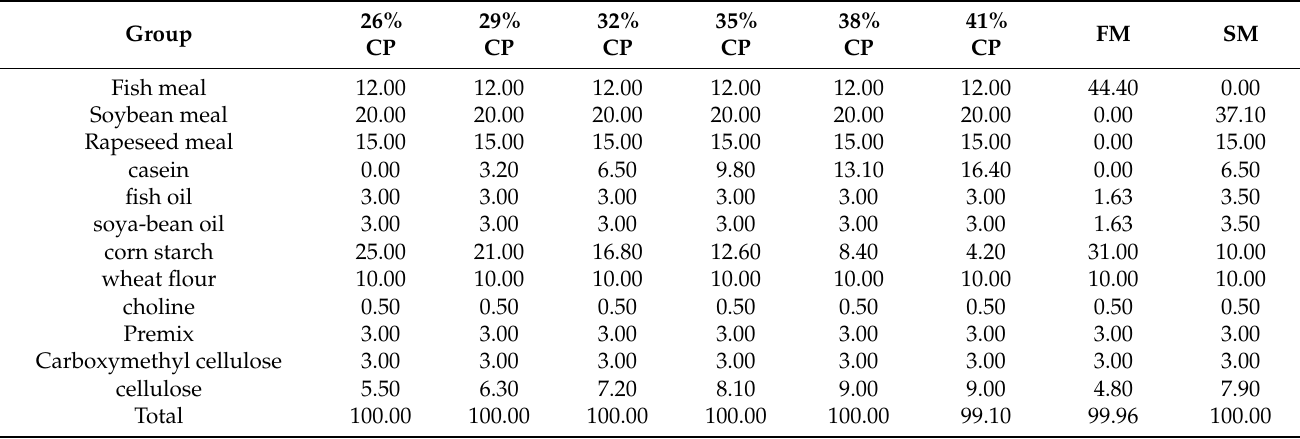
Table 4. Experimental diet compositions with different protein levels and dietary